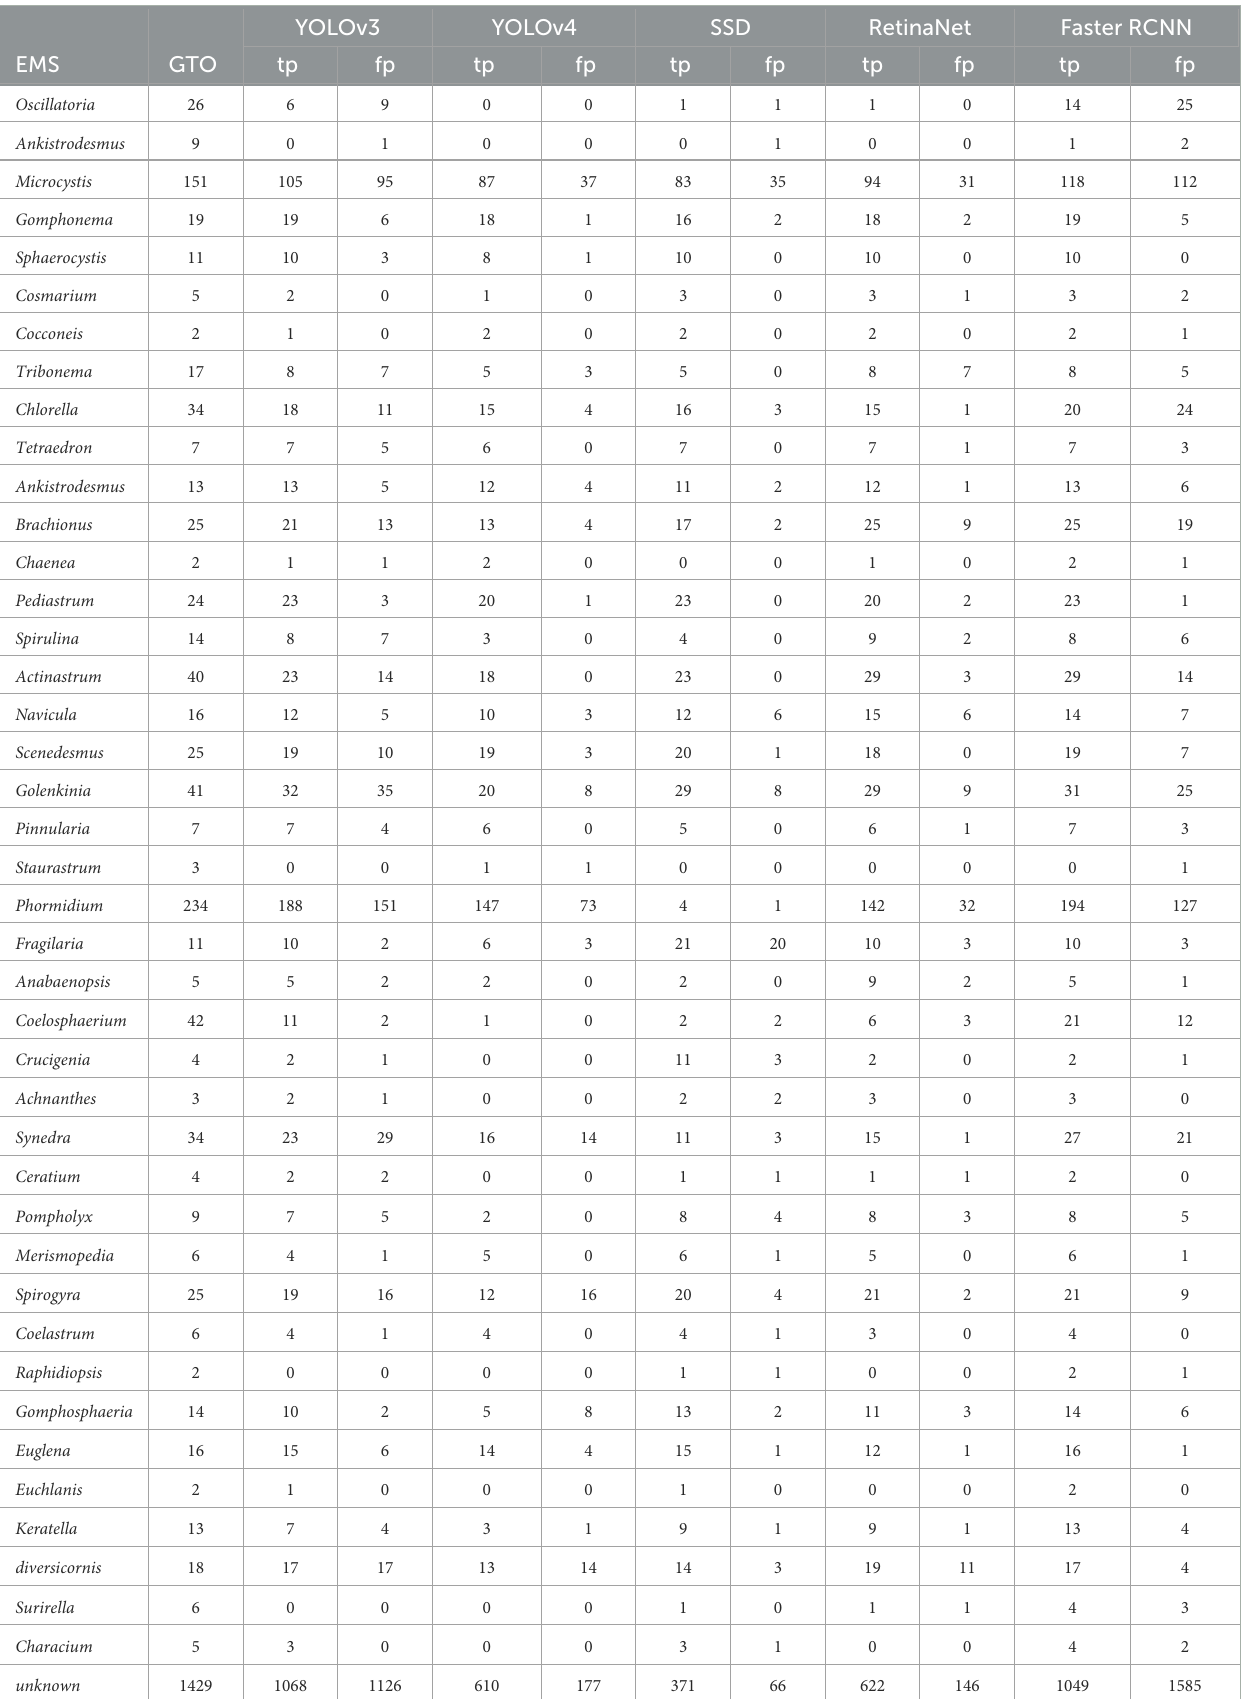
TABLE 2 A comparison of the object detection results on test set of